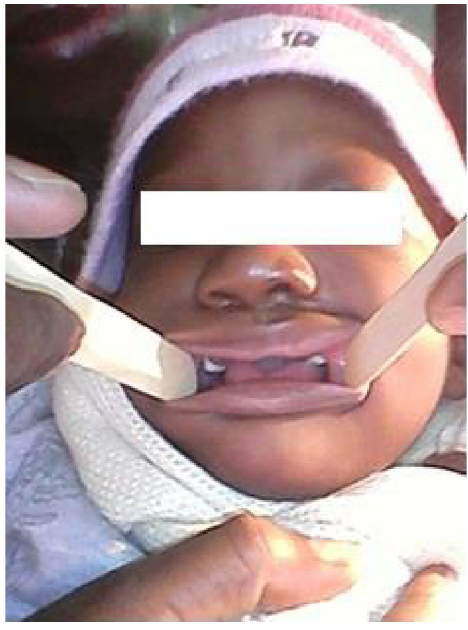
Fig. 8. Edentulous maxillary incisor region and oligodontia.